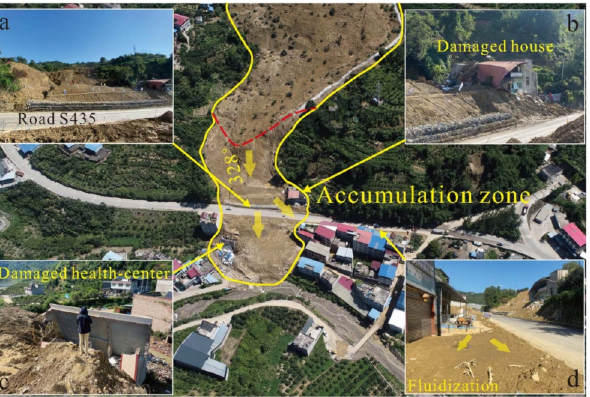
Figure 9. Photographs showing landslide impacts in the accumulation zone. ( a ) Reinforced gabion con- ducted for the road restoration. ( b , c ) Damaged houses and health-center. ( d ) Fluidization